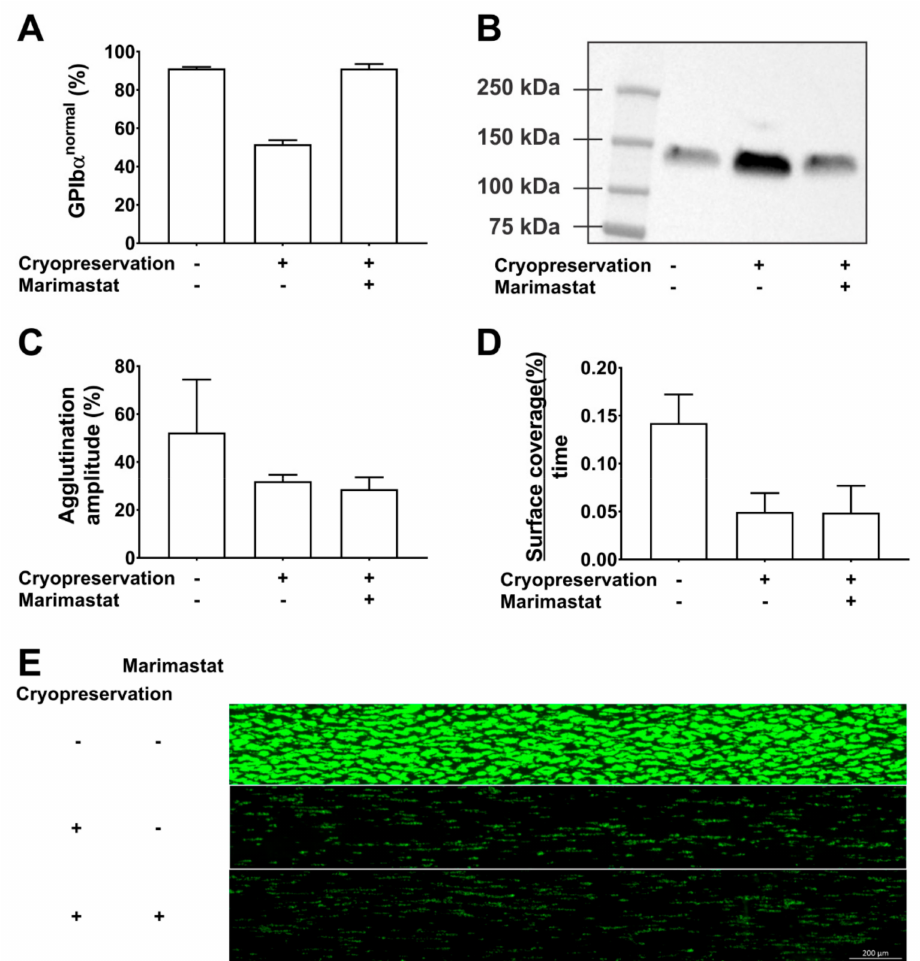
Figure 2. Inhibition of GPIb α shedding during cryopreservation. The e ff ect of cryopreservation in the presence or absence of 10 µ M marimastat was investigated. Comparison was with paired samples before cryopreservation. The methods used have been described in detail before [17,37,40]. ( A ) The percentage of GPIb α normal platelets was determined by CD42b measurements in flow cytometry. ( B ) Glycocalicin levels were determined by western blotting of platelet-free supernatant. ( C ) The agglutination amplitude of the platelets was measured in light transmission aggregometry using 1.25 mg / mL ristocetin. ( D ) The platelet surface coverage (%) as a function of time was determined by video microscopy of microfluidic flow chambers coated with collagen. Reconstituted whole blood spiked with 250,000 fluorescently labeled platelets per µ L was perfused at a wall shear rate of 1000 s − 1 . ( E ) Representative endpoint image of fluorescently labeled adherent platelets after 6 min of